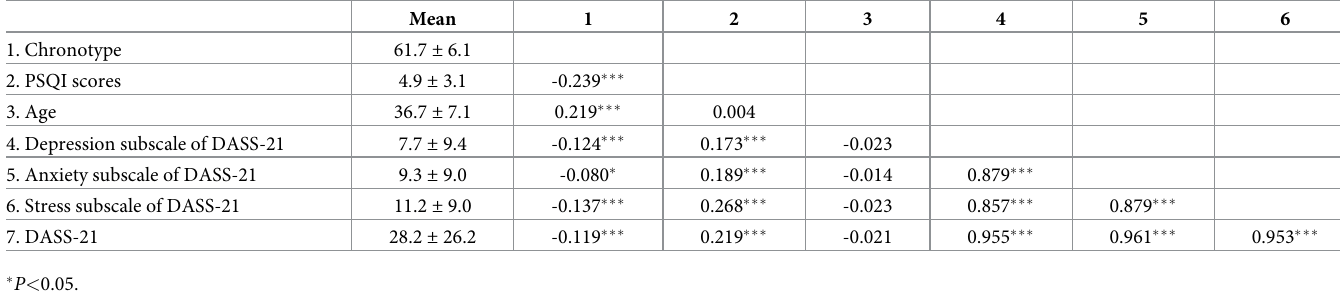
Table 2. Bivariate correlations among chronotype, PSQI scores, age, psychological distress and its subscales (n =